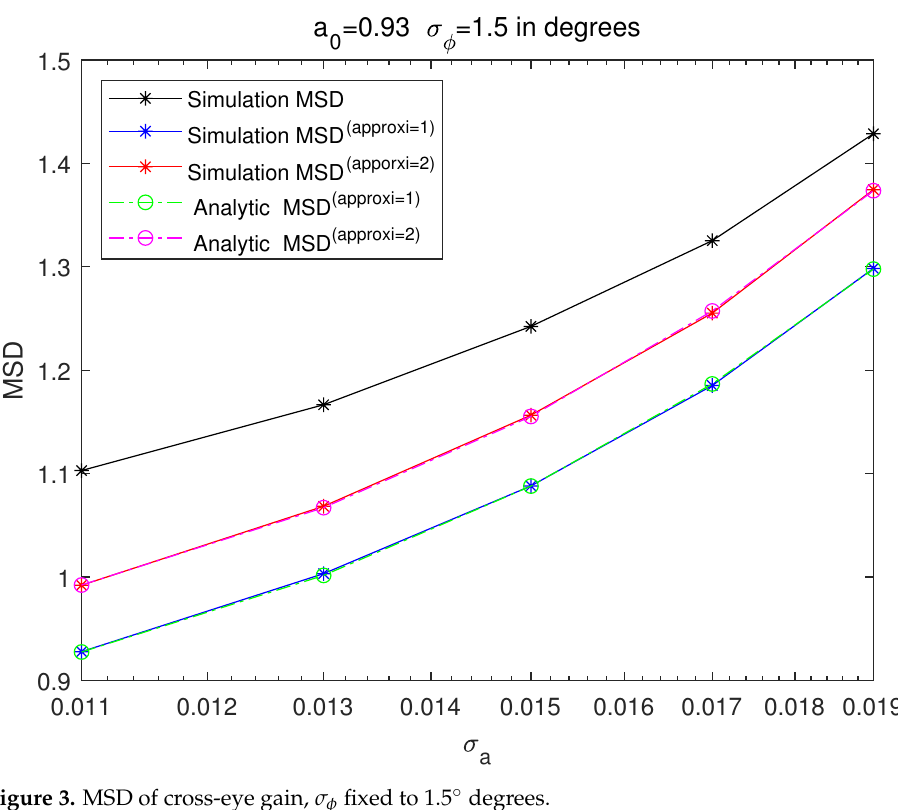
Figure 3. MSD of cross-eye gain, σ φ fixed to 1.5 ◦ degrees.